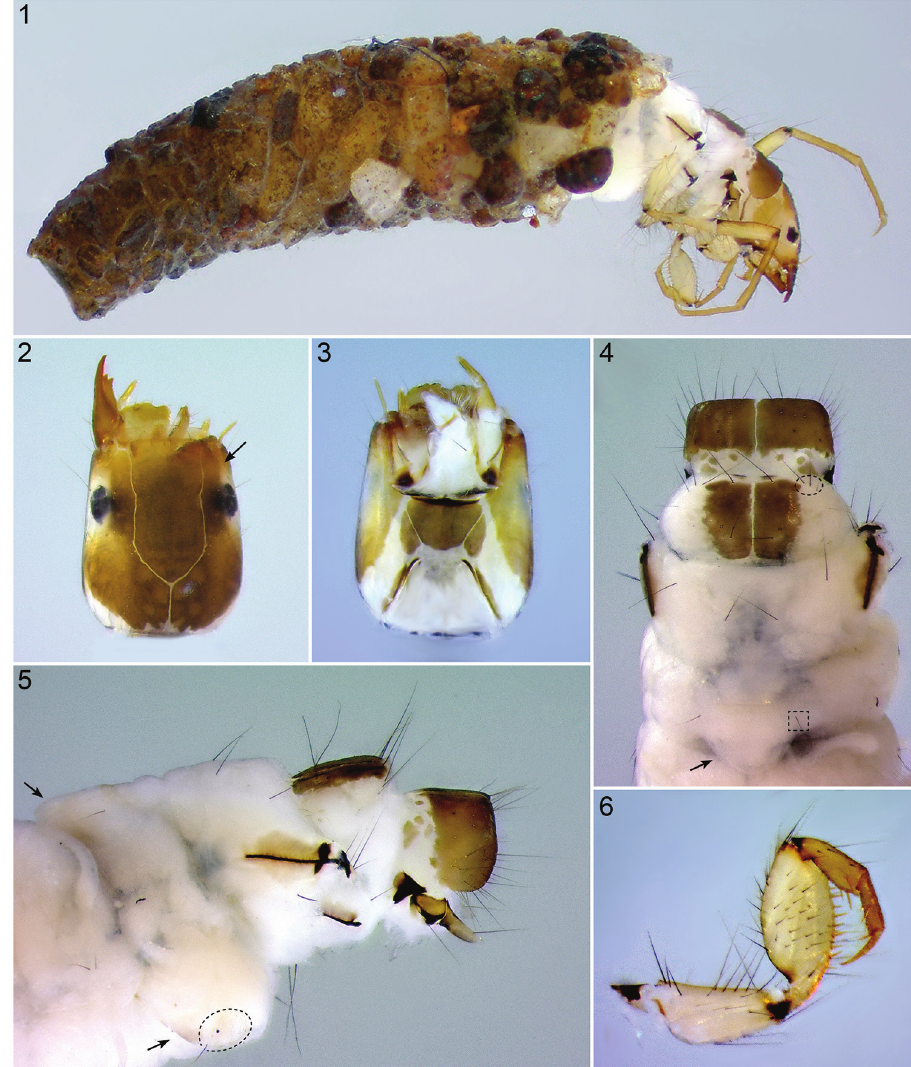
Figures 1–6. Oecetis mizrain , 5 th instar larva . 1 Larva with the case, 14× 2 Head, dorsal view (arrow indi- cates subocular ecdysial line), 50× 3 Head, ventral view, 65× 4 Thorax (Pro-, Meso- and Metanotum) and abdominal segment I, dorsal view (dashed oval indicates mesonotal sa , dashed square indicates adominal 3 segment I sa , arrow indicates abdominal segment I dorsal protuberance), 45× 5 Thorax and abdominal 2 segment I, lateral view (arrows indicate abdominal segment I dorsal and lateral protuberances, dashed outline indicates abdominal segment I lateral sclerite), 45× 6 Left front leg, anterior face, 80×. primary setae. Mandible slender, elongate, with single cutting edge and 3 teeth. Ventral apotome isosceles trapezoidal, rounded corners. Antennae near distal parietal border (Fig. 2), long (more than 6× longer than wide) and with single terminal seta (Fig.